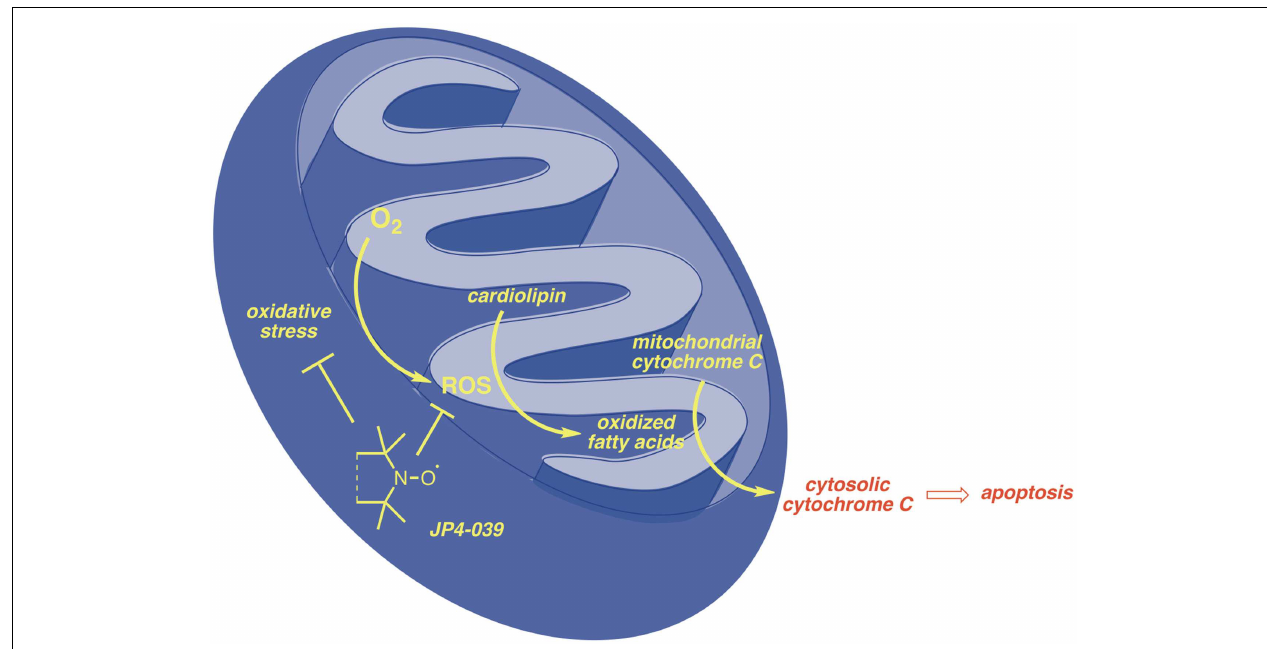
FIGURE 1 |Target of JP4-039 is the mitochondrial mechanism of irradiation-induced apoptosis .